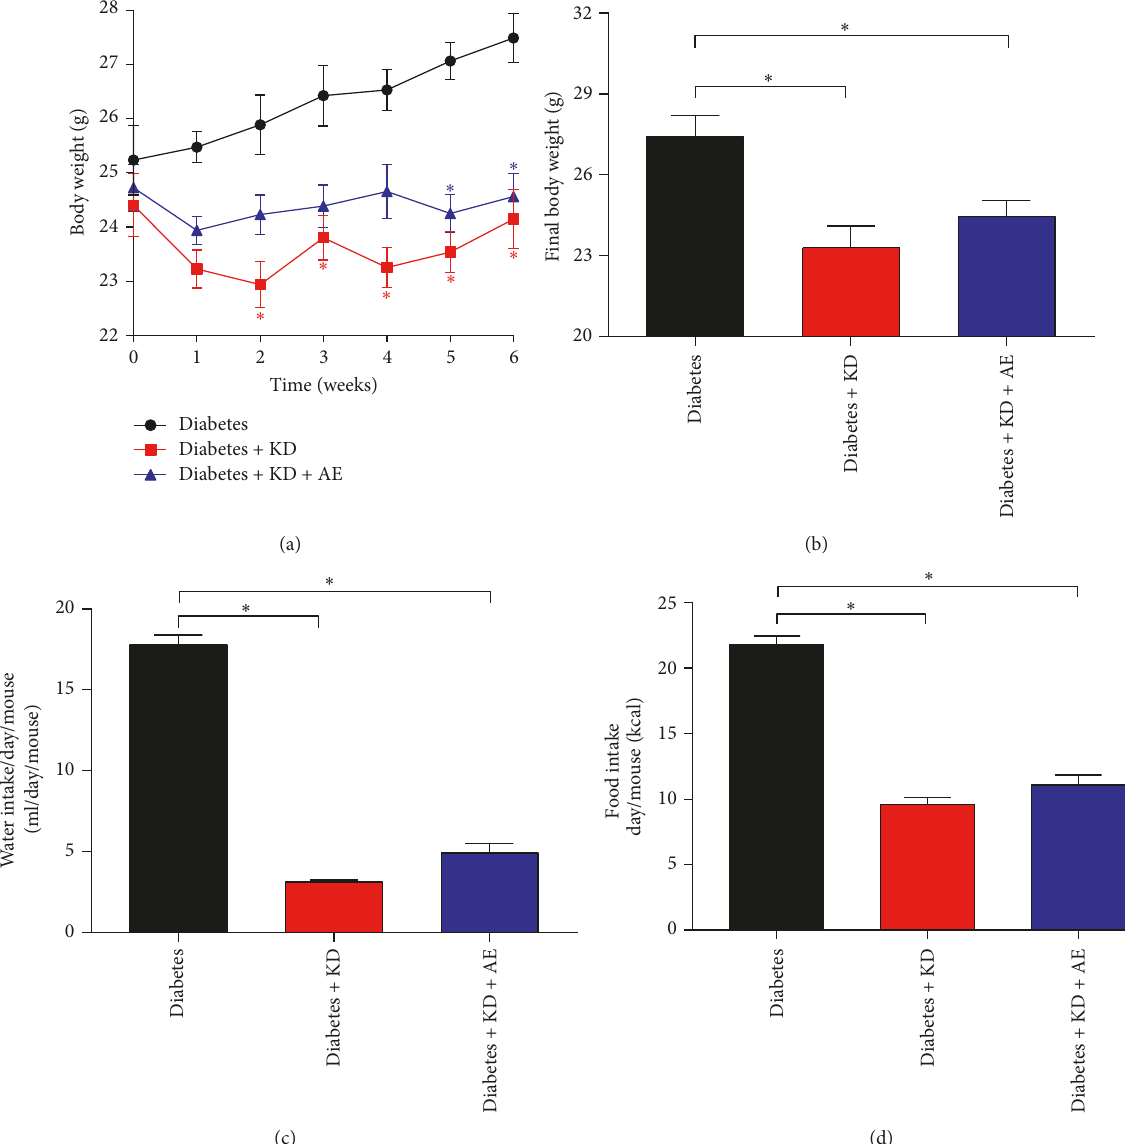
Figure 1: Ketogenic diet and ketogenic diet combined with exercise reduce body weights. (a) Changes in body weight during the 6-week treatment of ketogenic diet and aerobic exercise. Mice body weight of the diabetes + KD + AE group was significantly lower than that of the diabetes group, from the 5th week till the end. (b) Both ketogenic diet and a combination of aerobic exercise intervention could significantly decreased mice body weight. (c) Food intake and (d) water intake of diabetic mice were reduced after ketogenic diet or exercise. Data were presented as means ± SEM ( 𝑛 = 6 per group) and statistical analysis was performed with 1-way ANOVA. ∗ 𝑃 < 0.05 versus diabetic